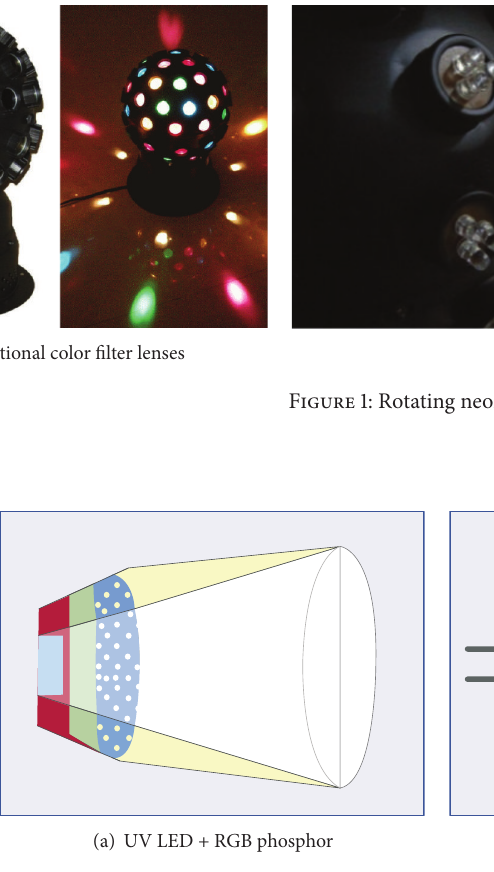
Figure 2: Two methods of generating light from LEDs